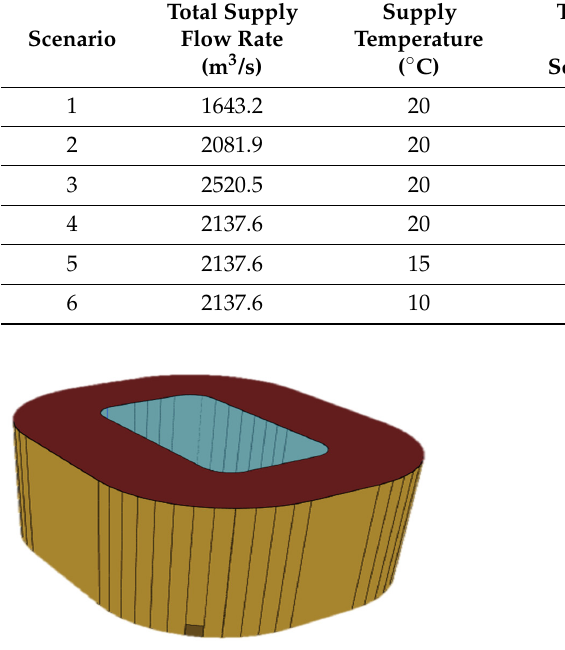
Table 4. EnergyPlus building and HVAC model parameter settings.